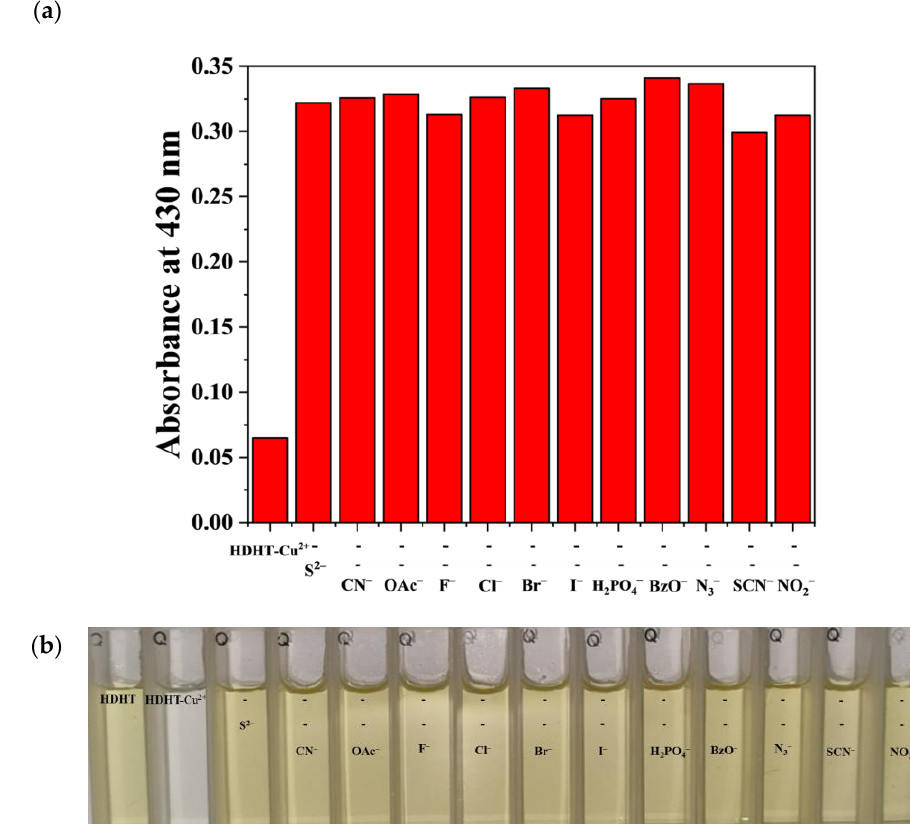
Figure 9. Inhibition test. ( a ) Absorbance of HDHT –Cu 2+ complex (30 µ M) at 430 nm in the presence of S 2 − (51 µ M) and other anions (51 µ M). ( b ) Photograph of color changes of 30 µ M HDHT -Cu 2+ solution in the presence of S 2 − (51 µ M) and other anions (51 µ